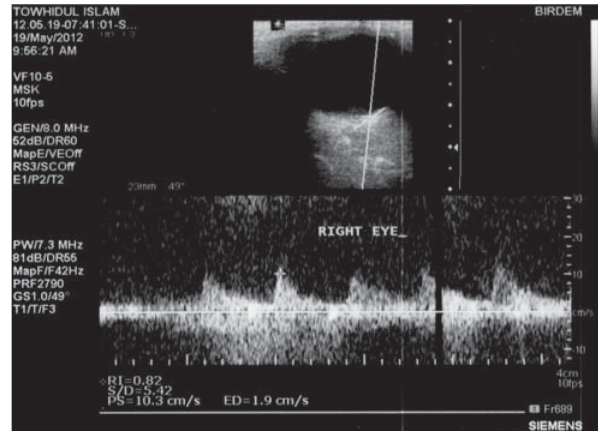
Fig 2. Spectral Doppler flow patterns of retinal artery of right eye in a type 2 diabetic subject